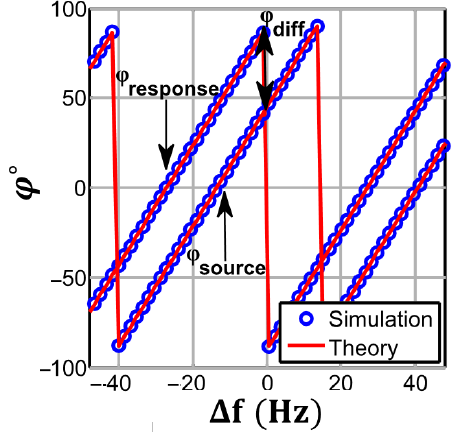
Figure 10. 3PSF initial phase estimation vs. source frequency deviation for ϕ source = 45 ◦ , ϕ response = 90 ◦ . The plots obtained for N = 1024, M = 19. When the frequency of the source and response signals is generated from a mutual source, the linear phase estimation error for both has the same